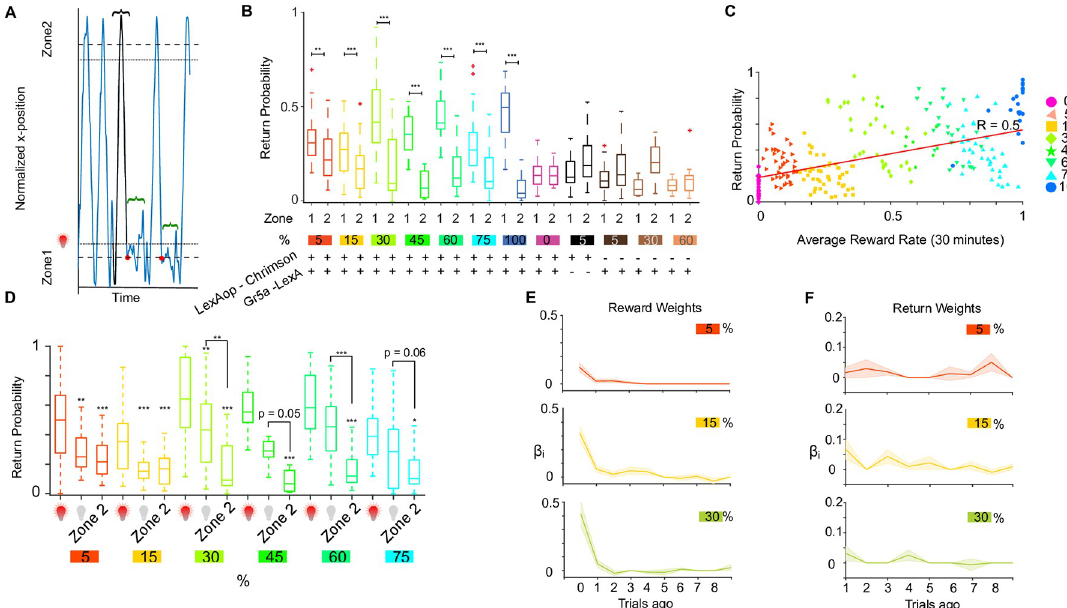
Fig 2. Flies return to optogenetic stimulation site. A Walking trace of one example fly over time in blue. Zone boundaries for reset zone are marked with dashed and for reward zone with dotted lines. Definition of a trial (highlighted trace in black) that consists of travel trajectory from entering the reset and reward zone, exiting the reset zone until entering the reset zone again in that order. Returns are defined as trials with walking trajectories that leave the reward and reset zone and return to the same reward zone, before reaching the other side’s reset zone boundary. Black trace with the curly bracket represents a case for non return behaviour. Two examples of returns are shown in green curly brackets. B Total return behavior per probability condition to zones 1 and 2 ( � : p < 0.05; �� : p < 0.01; ��� : p < 0.001, Mann Whitney U test) for stimulated flies and genetic controls ( LexAop-Chrimson /+ and Gr5a-LexA /+) shown as box plots (median, quartiles, full range and outliers in red crosses are shown). Number of animals for each condition is the same as in (Fig 1F). C Return probability versus average reward probability within 30 minute behavioral session. Black line: Pearson correlation, R = 0.5, p = 1e-16 (Robust Correlation package by [32]). D Return behavior on rewarded trials (red light bulb), unrewarded trials (grey light bulb) and unrewarded zone 2. ( � : p < 0.05; �� : p < 0.01; ��� : p < 0.001, Kruskal-Wallis test with multiple comparisons). Same number of animals were used as in (Fig 1F). E Logistic regression against the reward history. Solid lines: Population averages, shaded regions: ± SEM. Only significant coefficients (p < 0.01, computed using t-statistics) are shown. F Logistic regression of the return choices in the 5%, 15% and 30% condition against choice history for 10 trials into the past. Solid lines: Population average, shaded regions: ±